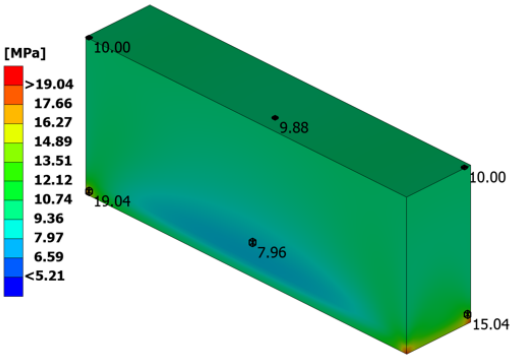
Figure 5. The results of the V05 static analysis (polymer concrete No. 15).